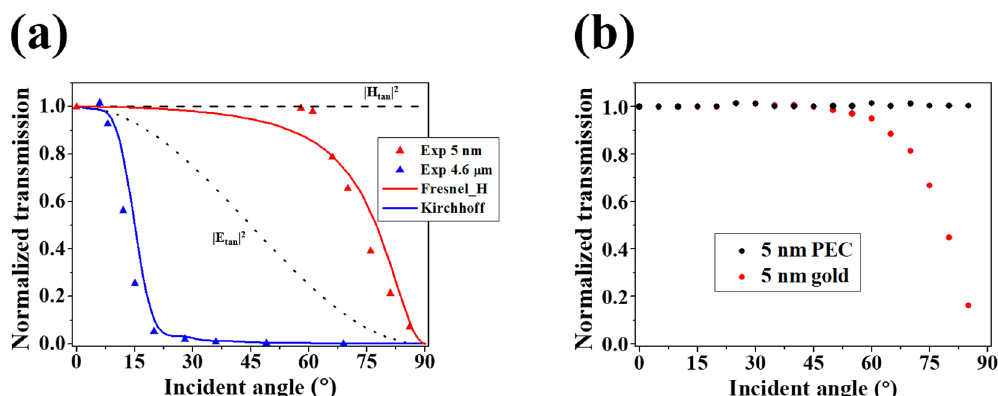
Figure 2. ( a ) Experimental results of transmission intensity versus the incident angle for the 5-nm slit (red triangles) and the 4.6- μ m slit (blue triangles). Transmission through the 5-nm slit is almost constant up to 60 degrees and shows similar incident angle dependence with the magnetic field intensity on the metal film given by the Fresnel equations (red solid line). The black dashed and dotted lines indicate the incident tangential magnetic and electric field intensities, respectively. The 4.6- μ m slit is in accordance with the Kirchhoff approximation (blue solid line). ( b ) Transmission through the PEC (black circles) and gold (red circles) 5-nm gaps with varying incident angle obtained by FEM